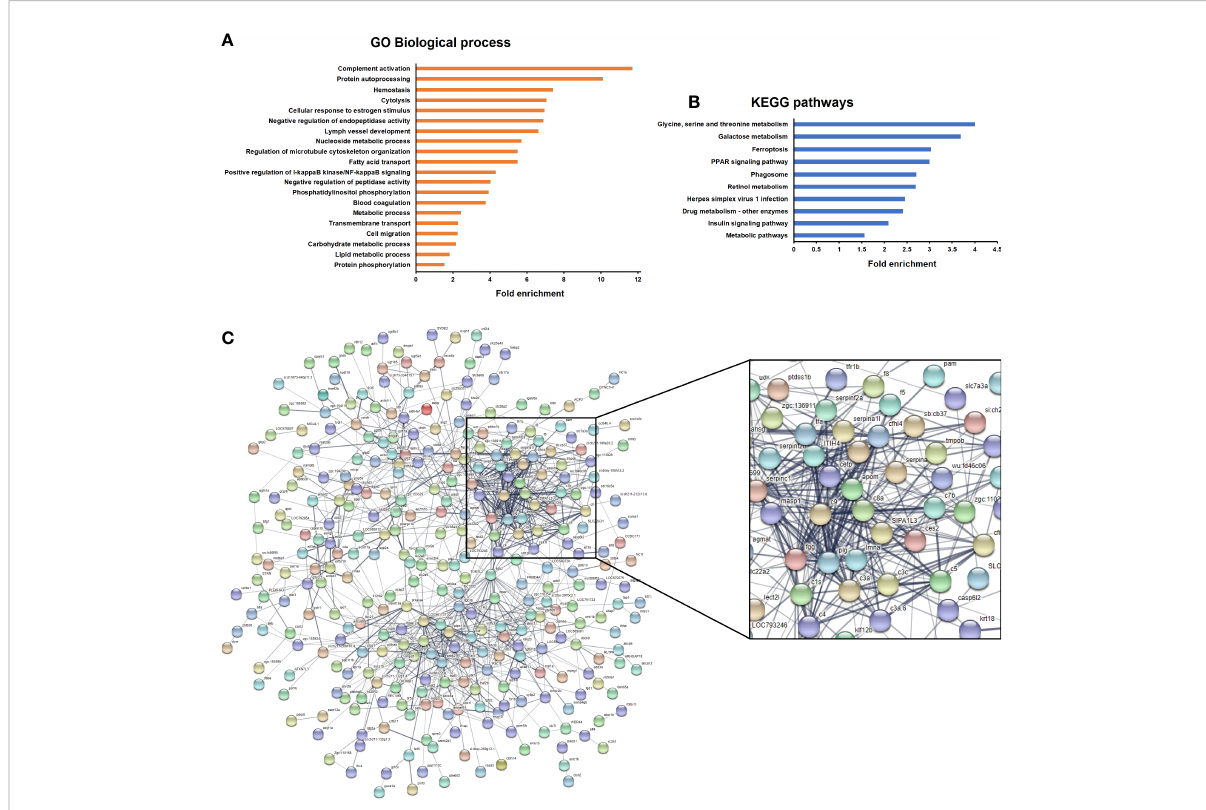
FIGURE 6 Enrichment analyses of the genes signi fi cantly modulated in the intestine of fi sh after exposure to antibiotics compared to the DMSO-treated group. (A) Signi fi cantly enriched GO biological processes. (B) Signi fi cantly enriched KEGG pathways. (C) String protein − protein interaction network showing the main gene clusters modulated by exposure to